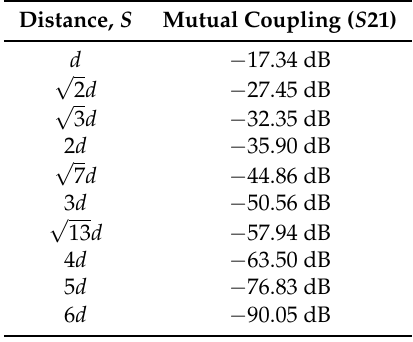
Table 4. The simulated mutual coupling results at 2.33 GHz with different S